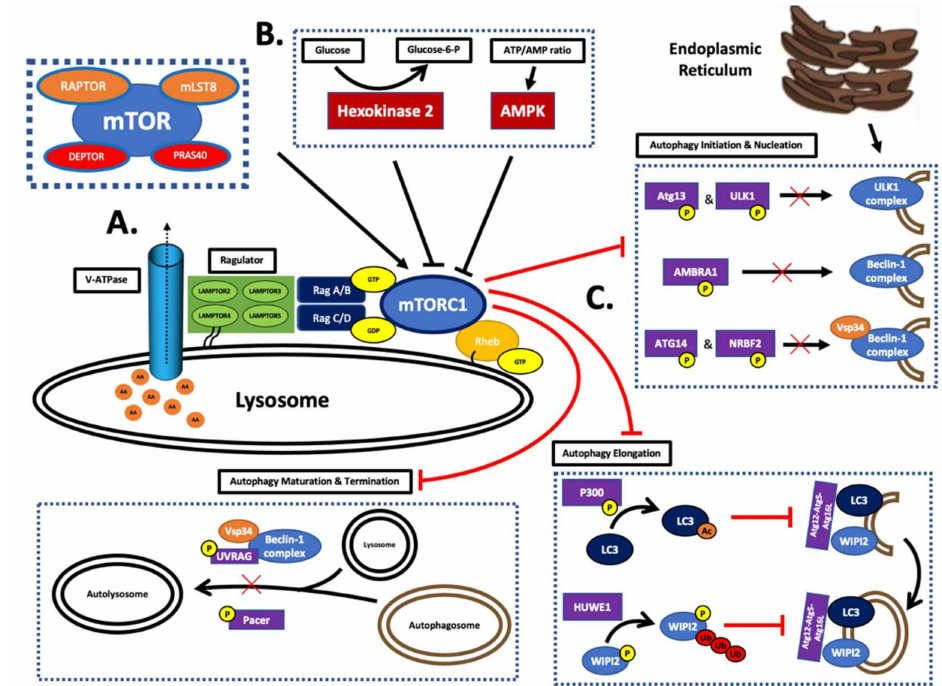
Figure 3. The role of mTORC1 in the control of autophagy. ( A ) The activation process of mTORC1 occurs at the lysosomal surface. It involves the detection of protein degradation in the lysosome by Rag, which is bound to the lysosome by Ragulator. The amino acids are released into the cytosol by V-ATPase. The activation of mTORC1 further requires the recruitment of Rheb in the GTP-bound form [31,53]. ( B ) The complex regulation of mTORC1 includes the incorporation of the nutritional status of the cell. Under low glucose conditions, enzymes in the glycolysis pathway inhibit mTORC1. Hexokinase can directly phosphorylate the mTORC1 complex and drive autophagosome formation to produce energy for the cell through lysosomal degradation. Furthermore, AMPK has also been shown to inhibit the mTORC1 complex. It reflects the ATP:AMP ratio of the cell [31]. ( C ) The mTORC1 complex prevents the formation of the autophagosome by the phosphorylation of multiple factors required for activation. During initiation, the pre-autophagosome buds off the endoplasmic reticulum. This structure is bound by the ULK1 complex that is constitutively assembled unless inhibited. The formation of this multi-protein molecule is regulated by mTOR activity. The mTORC1 complex targets two different subunits for inhibition, ATG13 and ULK1. Phosphorylation of either subunit prevents ULK1 complex formation and the subsequent phagophore. The following phase is known as nucleation and is conducted by Belcin1. This secondary protein complex is activated via ULK1 complex-induced phosphorylation. As a result, this complex begins generating PIP3 on the surface of the phagophore through its class III PI3K enzyme activity. The kinase function is performed by the catalytic subunit, Vps34. Under nutrient-rich conditions, mTORC1 inactivates the Belcin1 complex through the phosphorylation of Atg14, AMBRA1, or NRBF2. Autophagosome expansion is